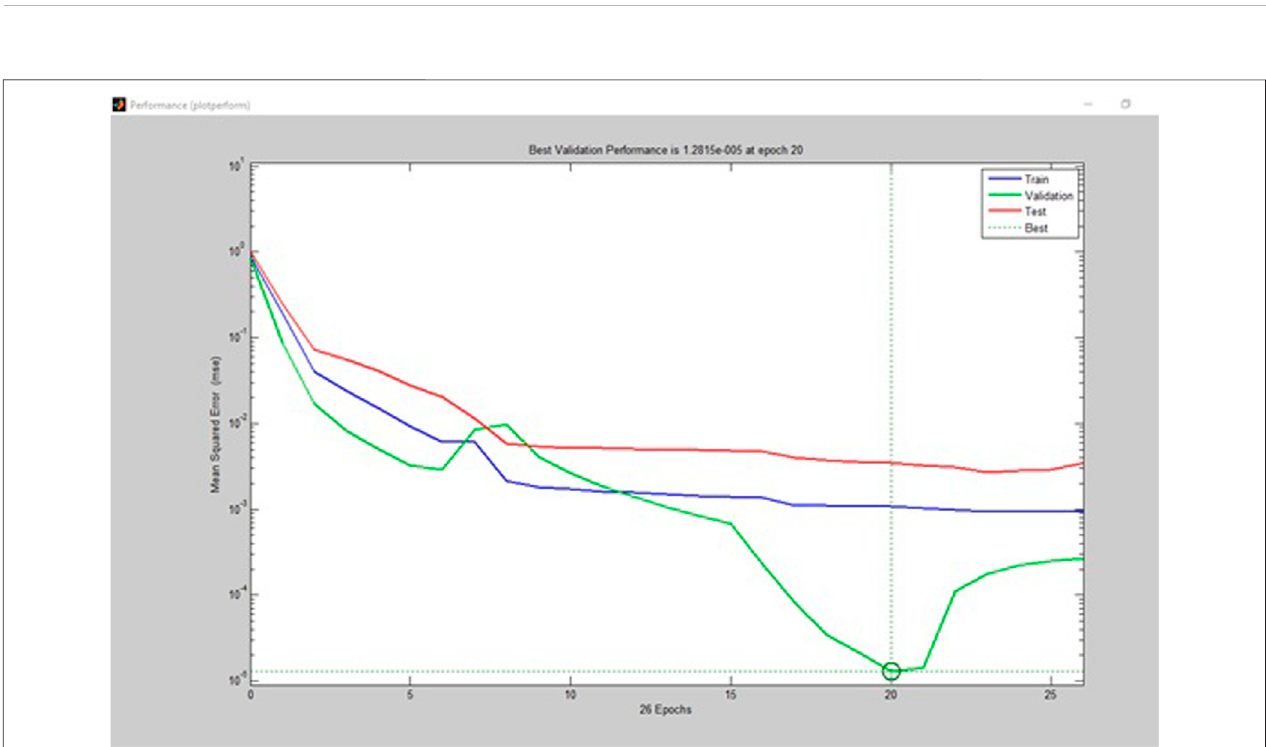
FIGURE 10 | Mean square error (MSE) for training, validation, and testing of the ANN-MPPT.